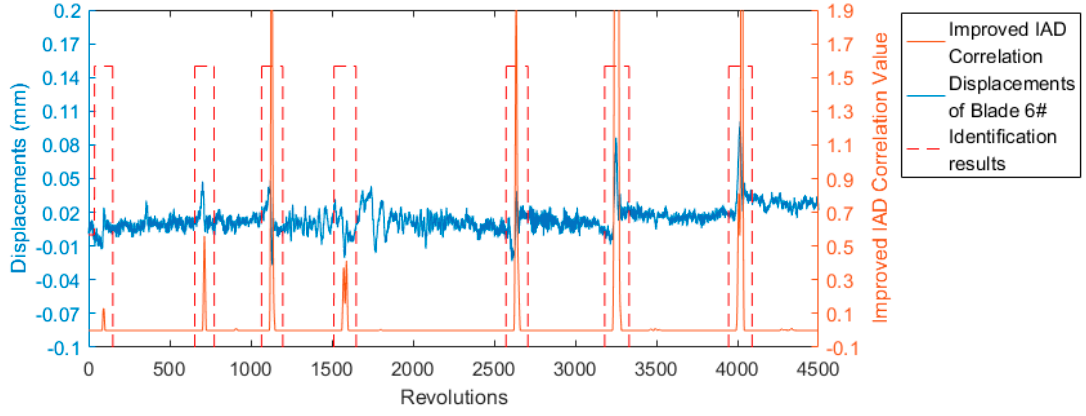
Figure 8. Identification results of blade 6# using Equation (5).